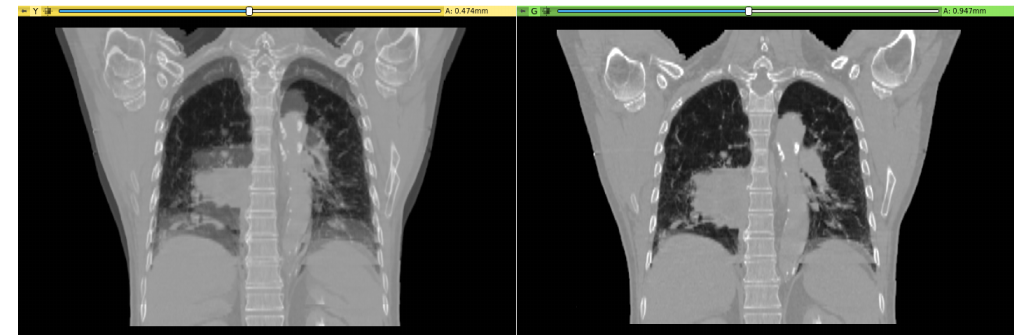
Figure 5. Computed tomography (CT) scans shown in overlay mode. In the left panel, before registration, it is possible to see the misalignment along the z axis. In the right panel, after linear registration, the displacement was accurately recovered. Listing 2. Python code for controlling a servomotor according to a translation identified by the alignment of two CT